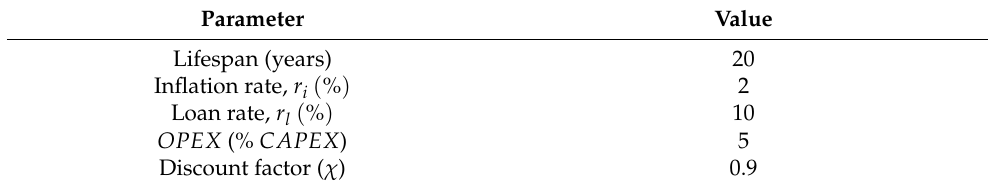
Table 3. Input parameters for the LCoE